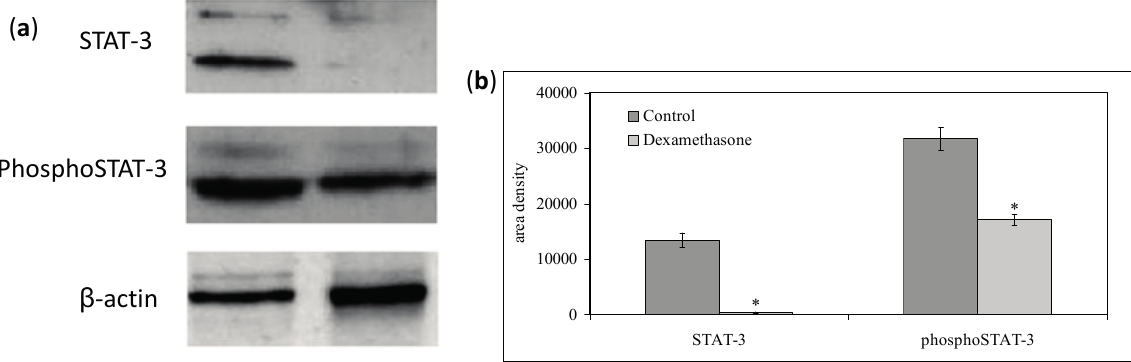
Figure 3. Effect of Dexamethasone on signal transducer and activator of transcription 3 (STAT3) and phospho signal transducer and activator of transcription 3 (phosphoSTAT3). ( a ) Immunoblots of proteins were probed with anti-STAT3 and anti-phospho-STAT3 and visualized by enhanced chemiluminescence (ECL). Apparent molecular weight for STAT3, phosphoSTAT3 and β -actin were 90, 92 and 43 KDa, respectively; ( b ) The area density was evaluated by densitometry scanning and analysis with Scion Image, the data represent the mean ± S.D. of three experiments performed in duplicate. (Significance, * p < 0.001 versus control